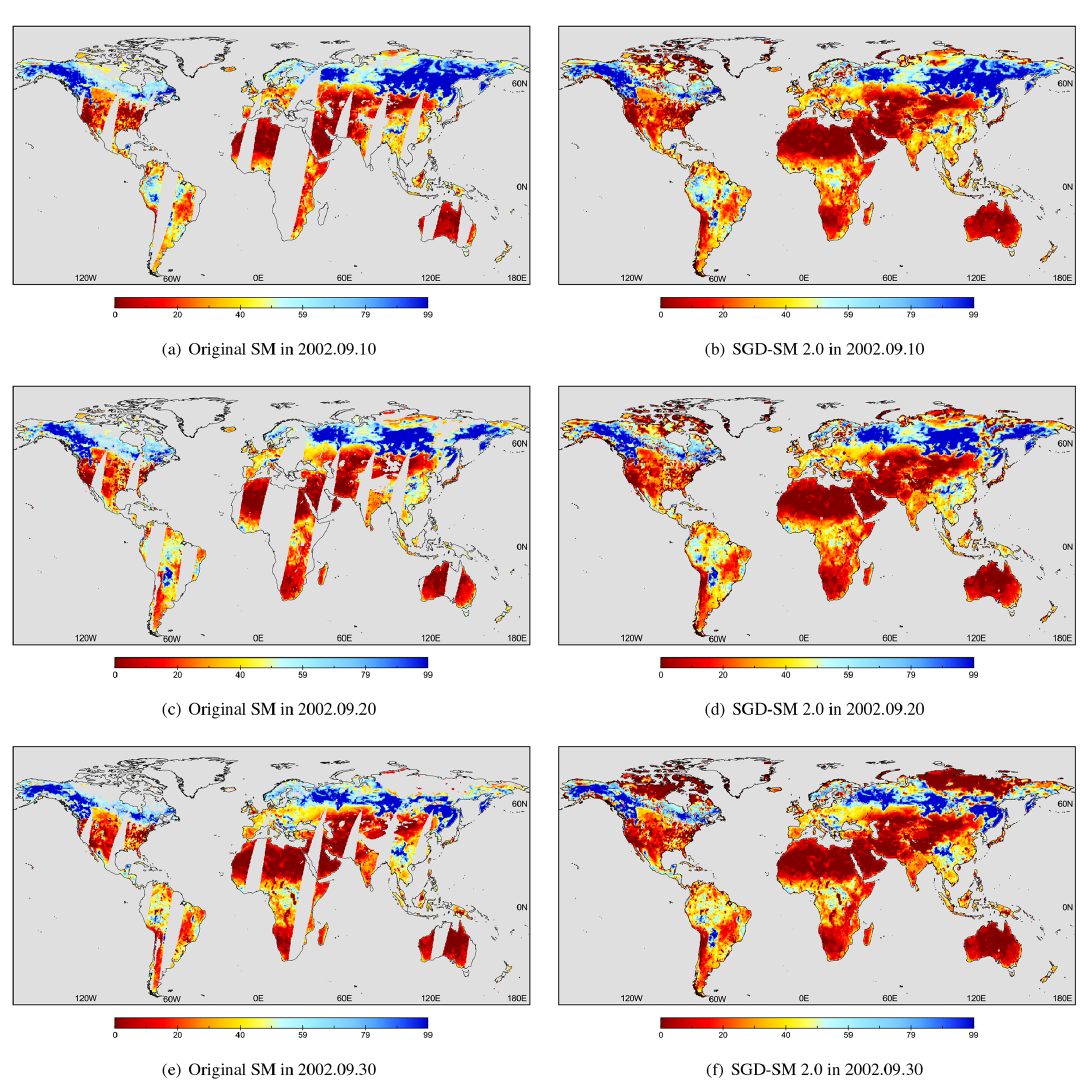
Figure 6. Original SM and proposed SGD-SM 2.0 results on 10, 20 and 30 September 2002. Table 1. Comparisons between the original SM and SGD-SM 2.0 products (from 2002 to 2022) in the 124 selected in situ